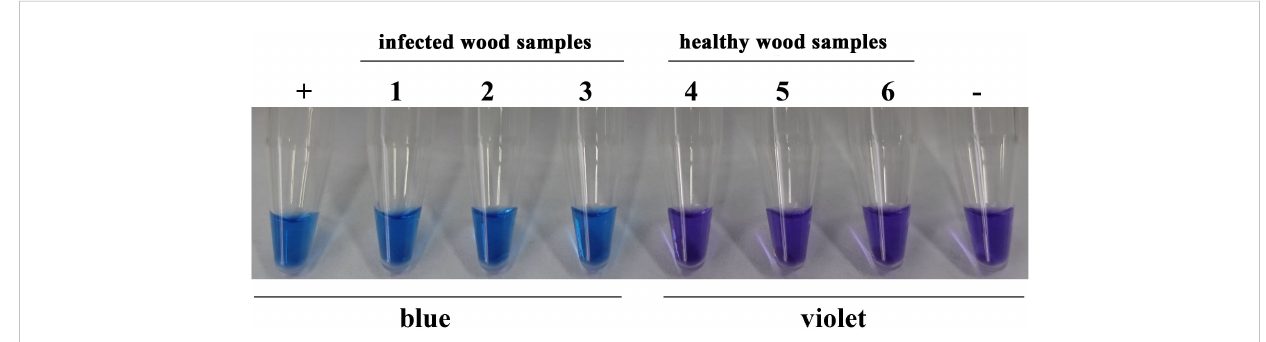
FIGURE 6 LAMP assay detection of H. annosum in wood samples. ” + ” : positive control; “ - ” : negative